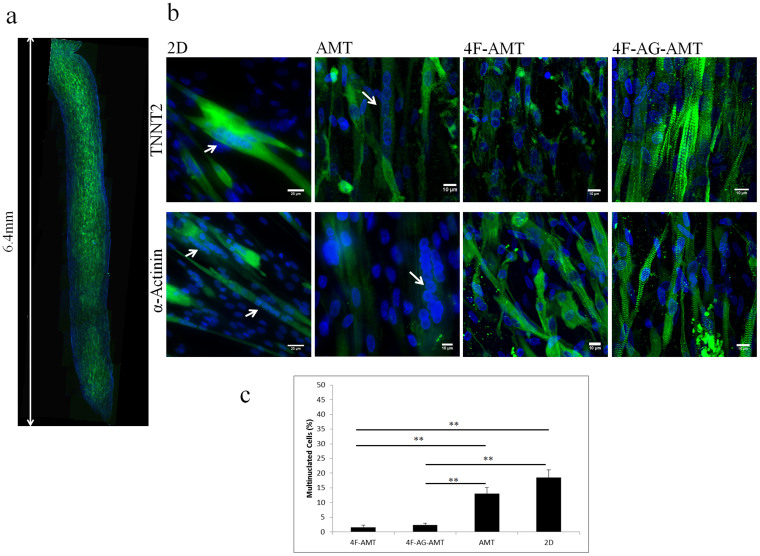
Histological Analysis of Day 14 Differentiated MDSCs.(a) Low magnification image of AMT showing α-Actinin expression throughout the construct, indicating MDSCs acquire a muscle phenotype. (b) Expression of α-Actinin and TNNT2 in MDSCs differentiated under various protocols. Scale bars indicate 10 μm or 20 μm as stated in each image. Arrows point to multinucleated cells. Blue indicates nuclear DAPI staining. (c) Percentage of multinucleated cells (n > 4 nuclei). 4-factor treatment significantly reduced the percentage of multinucleated cells. ** P < 0.001.